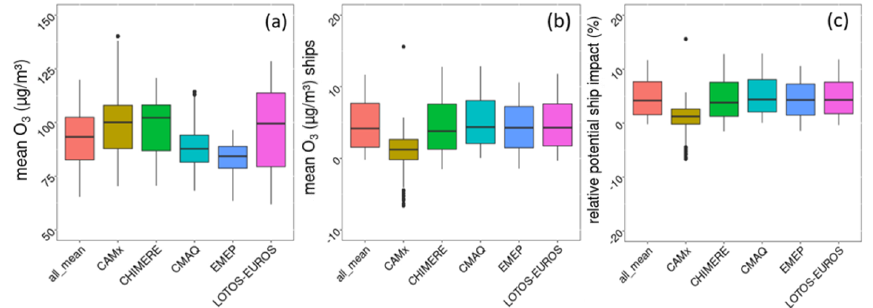
Figure 7. Annual mean for the whole model domain. (a) Mean O 3 for all emission sectors (base case); (b) mean O 3 for shipping only; (c) relative potential ship impact on total O 3 concentration. All_mean is the mean value of all models, with a median of (a) 92.4µgm − 3 , (b) 4.0µgm − 3 and (c) 4.2µgm − 3